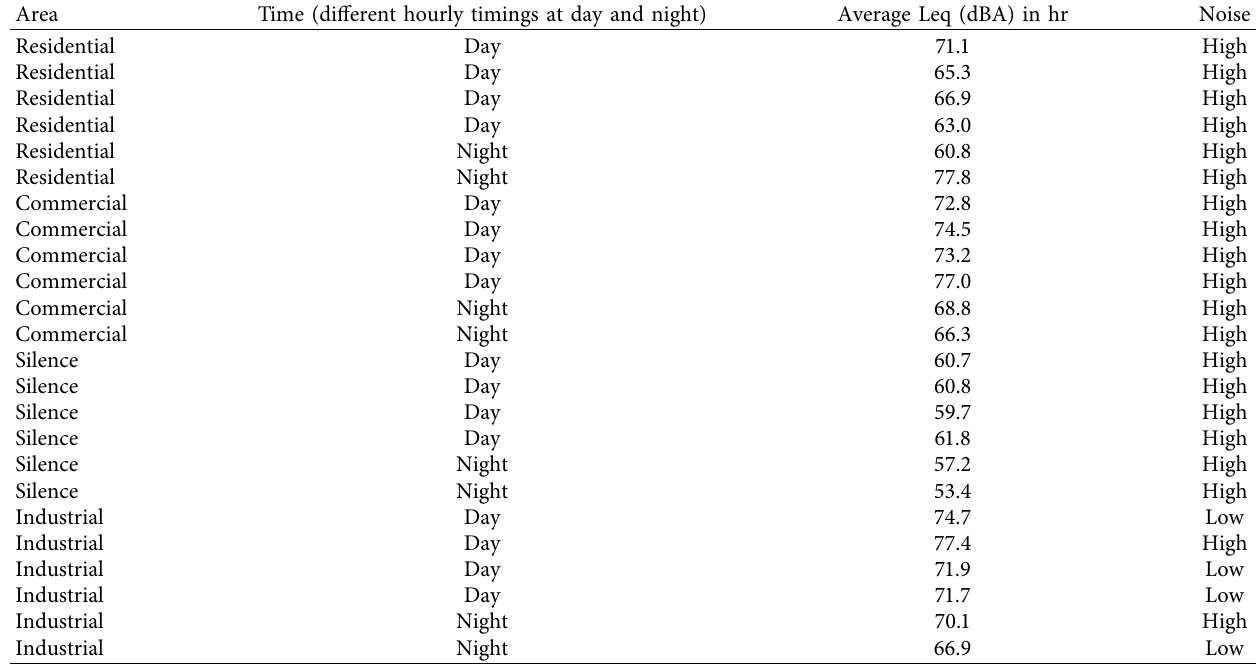
Table 1: Sample average data of year 2017 during Dussehra.